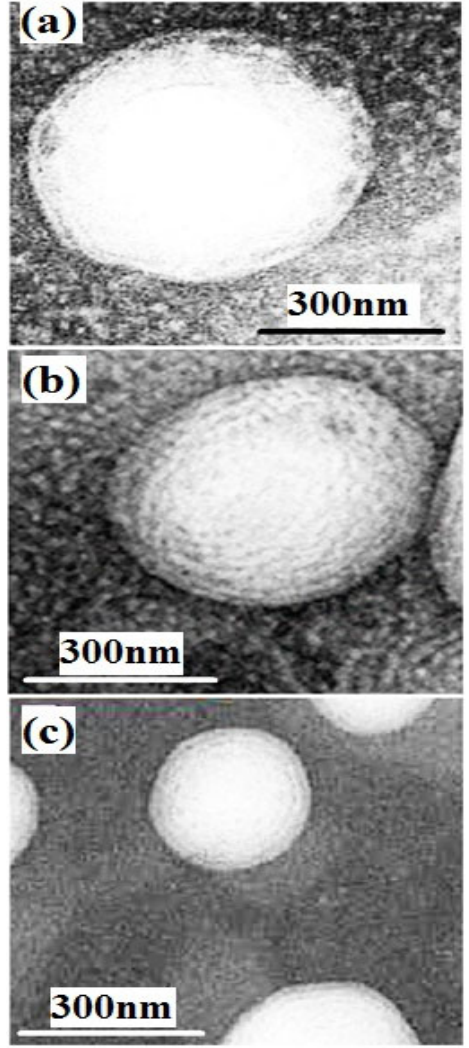
Figure 1. Morphology of nanoliposomes, ( a ) nanoliposomes coated with 1% chitosan, ( b ) nanolipo- somes coated with 0.5% chitosan, ( c ) non-coated nanoliposomes.